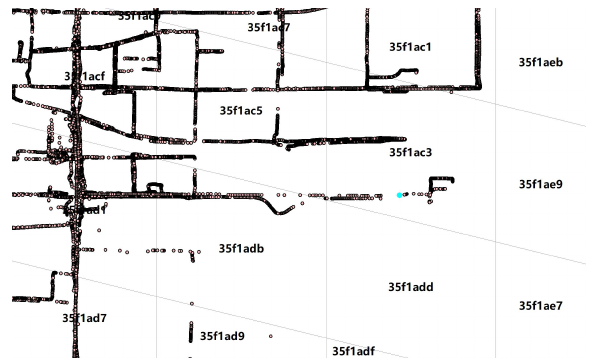
Figure 4. One trajectory on the 12 th level